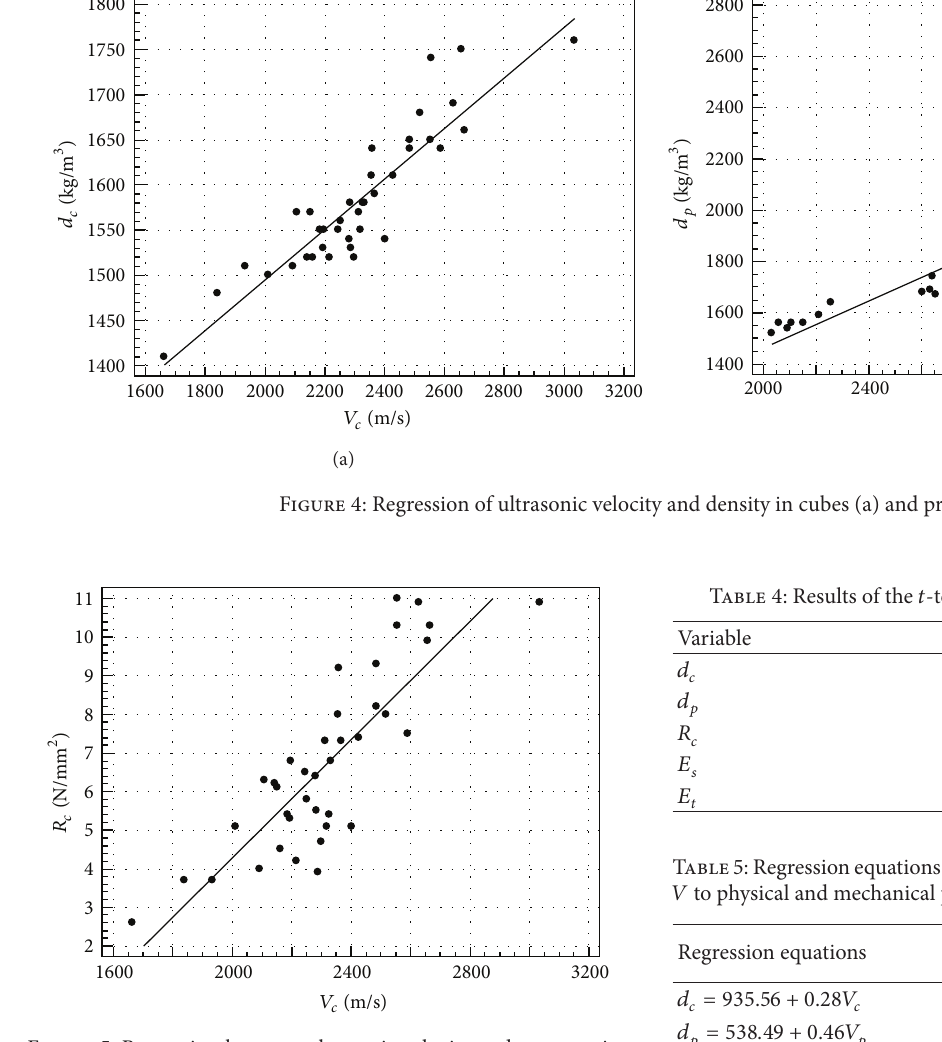
Figure 5: Regression between ultrasonic velocity and compressive strength in cubes.